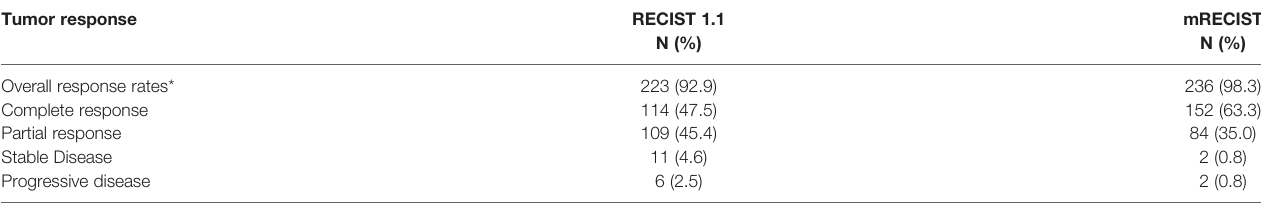
TABLE 2 | Tumor Response at three months after